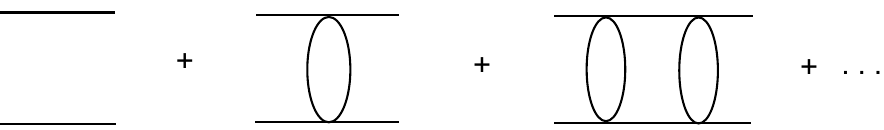
Figure 3. The fermion four-point function, at order 1 =N , is a sum of ladder diagrams. There are also crossed diagrams, which are not